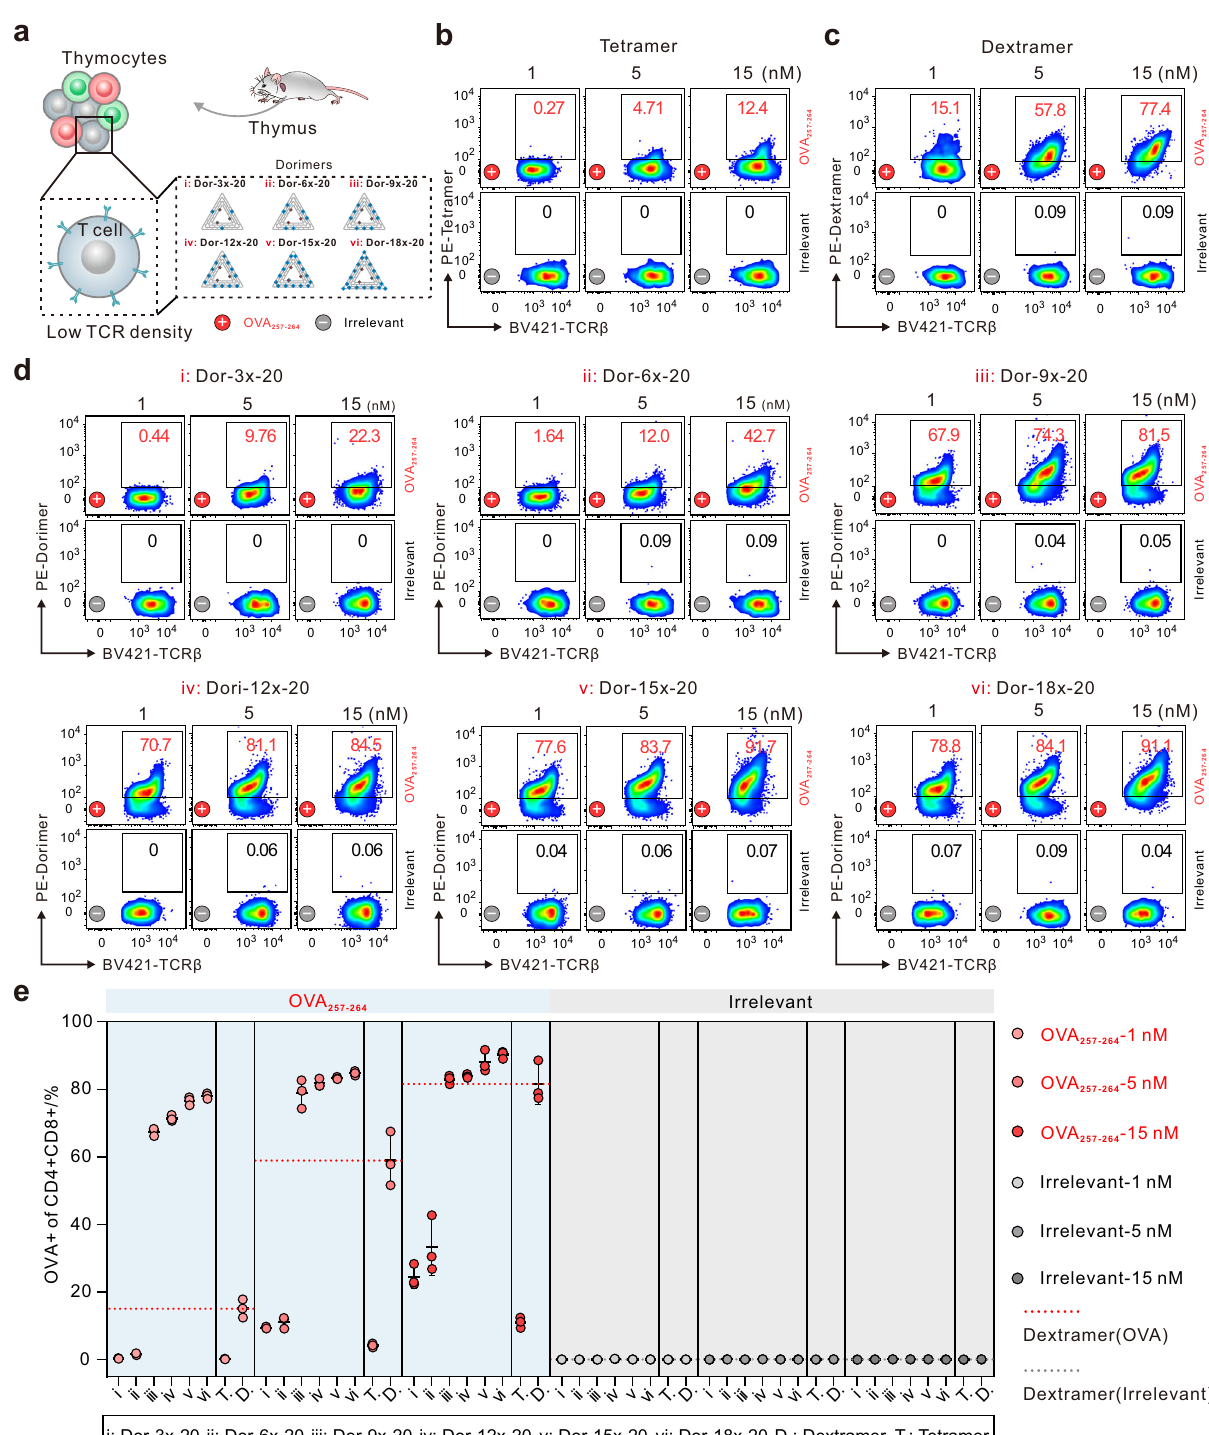
Fig. 4 Detection of double-positive CD4 + CD8 + T cells using dorimers. a Schematic illustrating phenotype analysis of OVA-speci fi c CD4 + CD8 + T cells from OT-1 transgenic mice thymus with six types of dorimers (i – vi). Antigen-speci fi c staining of OVA-speci fi c CD4 + CD8 + T cells by b tetramers, c dextramer, and d dorimers at different concentrations (1, 5, and 15 nM). pMHC multimers were made using H-2K b MHC loaded with either a speci fi c OVA peptide (SIINFEKL) ( + ) or an irrelevant peptide (SIYRYYGL) ( − ). The number in each panel represents the percentage of the identi fi ed OVA-speci fi c CD8 + T cells. e Statistical analysis of the percentages of the identi fi ed OVA-speci fi c CD4 + CD8 + double-positive T cells from OT-1 transgenic mice by dorimers, tetramers, and dextramer at different concentrations (1, 5, and 15 nM). The red and gray lines represent the percentage of OVA-speci fi c CD8 + T cells detected by the OVA 257 – 264 /irrelevant-dextramer, respectively. Blue shading: OVA peptide (SIINFEKL); Gray shading: irrelevant peptide (SIYRYYGL). Data represent the mean ± s.d. from n = 3 independent experiments. Source data are provided as a Source Data fi